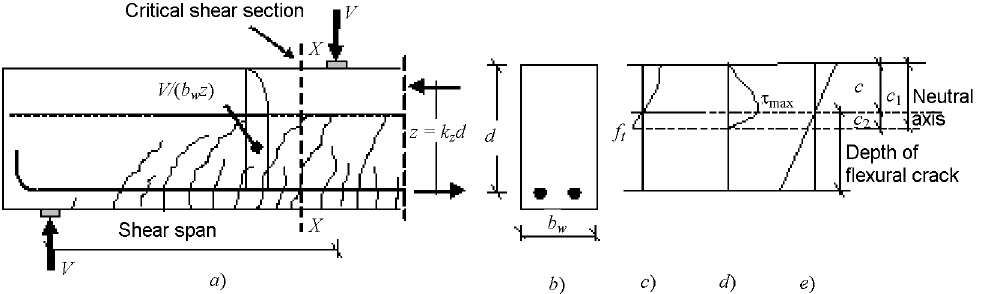
Fig. 1. Shear stress and strain distribution in a RC beam with flexural cracks: a) typical crack pattern and shear stress distribution (adapted from Cladera (2003)); b) cross-section X-X; c) distribution of concrete stresses (Khun- tia, Stojadinovic 2001); d) shear stress distribution (Khuntia, Stojadinovic 2001); e) longitudinal strain